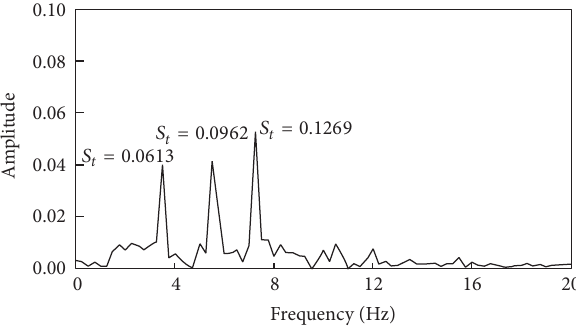
Figure 11: Power spectrum of the 𝐶 𝐿 (𝑡) of Case #0 under stationary condition ( 𝛼 = +5 ∘ , 𝑈 𝑟 = 2.092